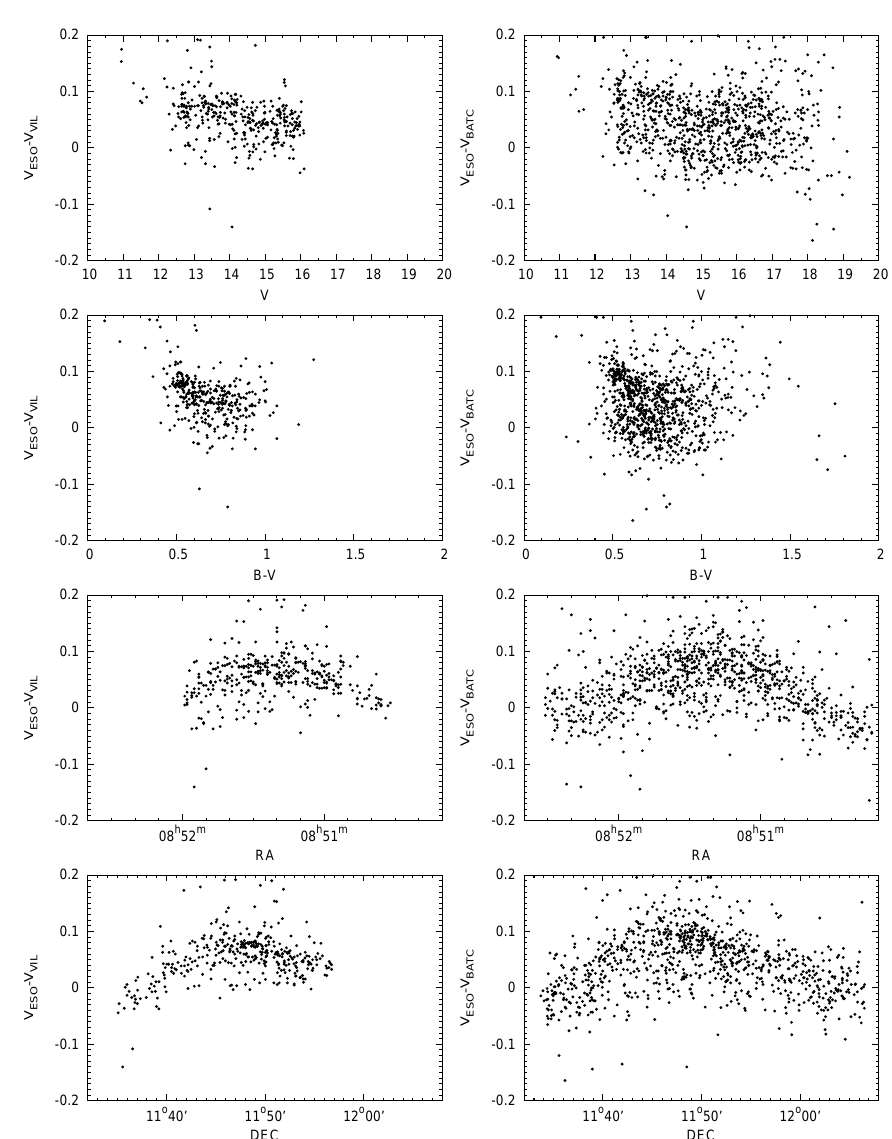
Fig. 2. Differences between V ESO and V VIL (left panels), and between V V ESO and BATC (right panels). Large-scale systematic errors up to 10% are seen in the ESO